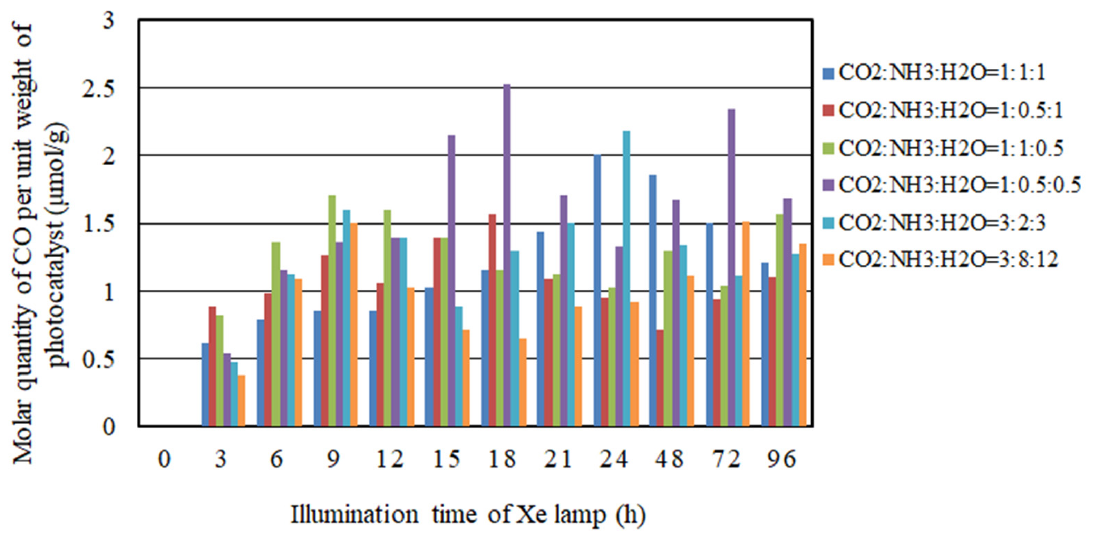
Figure 3. Comparison of molar quantity of CO per unit weight of photocatalyst under the illumination condition of Xe lamp without UV light. The pulse number is 100. The highest CO 2 reduction characteristic is obtained under the condition of the molar ratio of CO 2 /NH 3 /H 2 O = 1:0.5:0.5 where the molar quantity of CO per unit weight of photocatalyst is 2.52 mol/g.